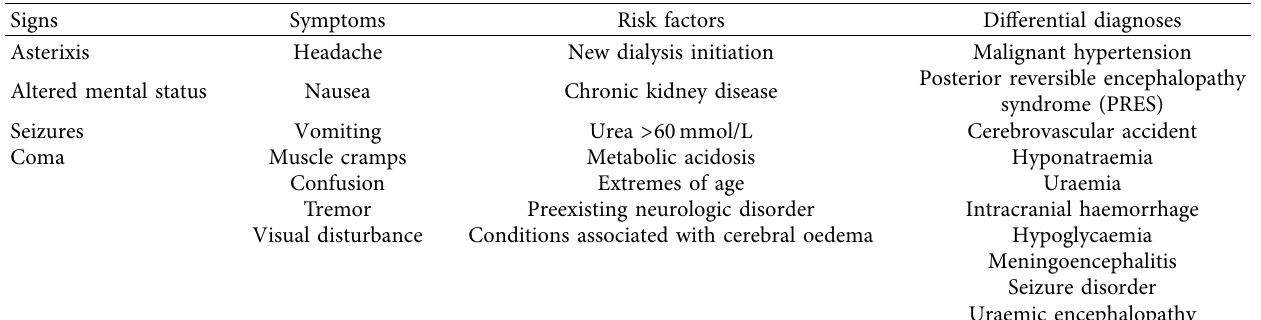
Table 1: Signs, symptoms, risk factors, and differential diagnoses for dialysis disequilibrium syndrome.